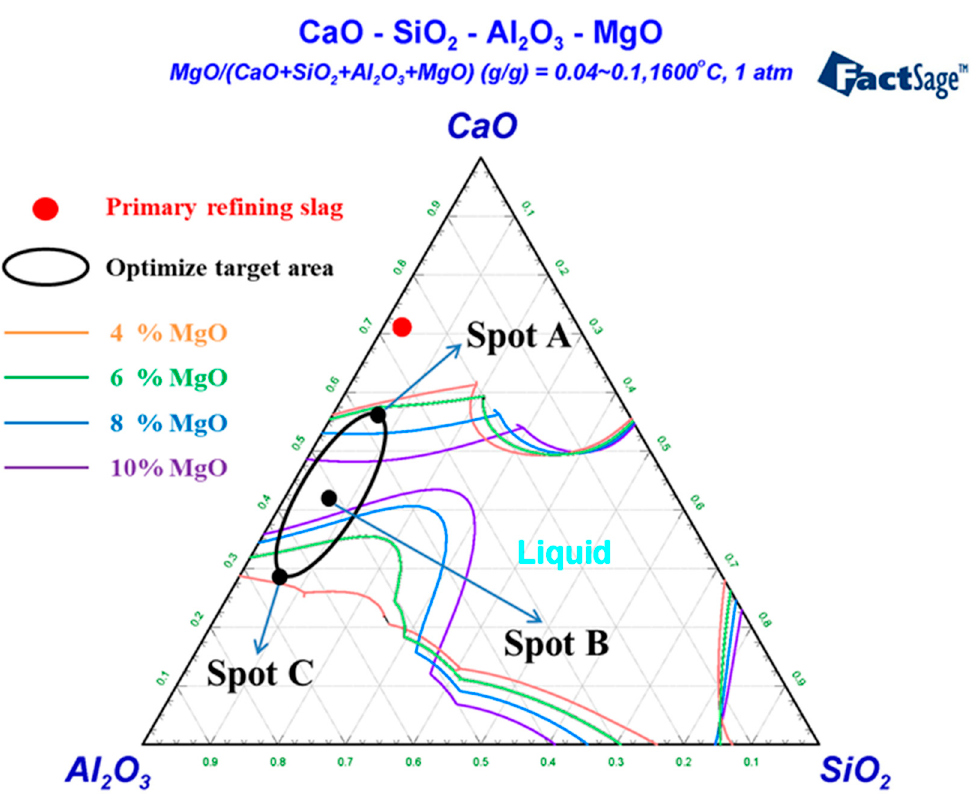
Figure 5. CaO – Al 2 O 3 – SiO 2 ternary phase diagram. Figure 5. CaO–Al 2 O 3 –SiO 2 ternary phase diagram.